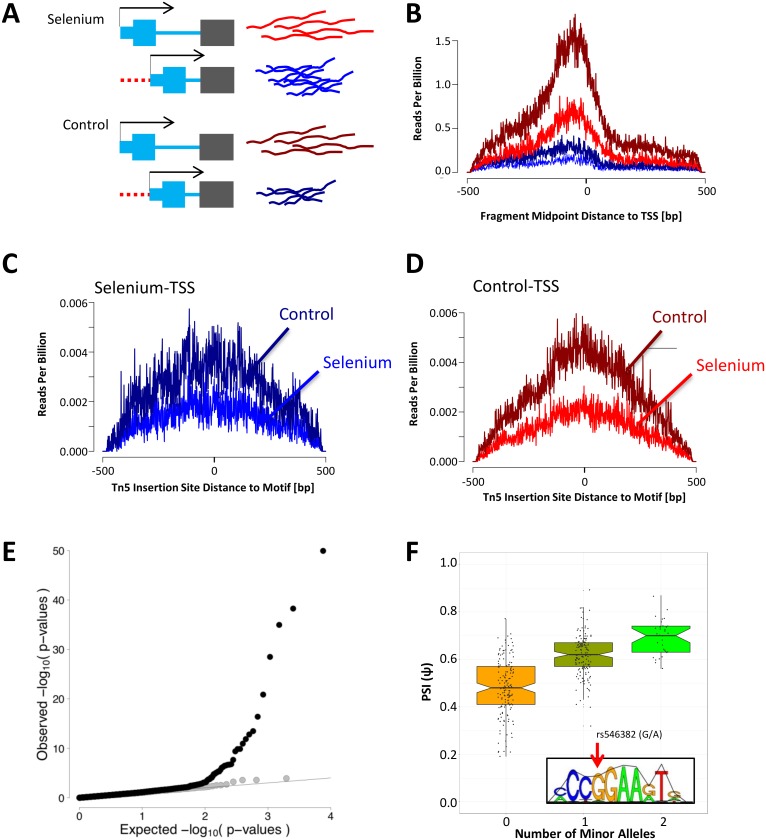
Binding of ELF2 impacts AFE shift following selenium treatment.A) Model illustrating the situation where transcription is shifted towards the downstream AFE following selenium treatment and demonstrates an example of a TSS that would be included in our analysis. B) Chromatin accessibility of TSS with significant shift in AFE following selenium measured by ATAC-seq (read count normalized to total reads in the library). Chromatin accessibility profiles derived from LCLs treated with selenium are bright blue or red, while profiles derived from LCLs treated with control are dark blue or red. Blue lines show accessibility at TSS to which the AFE shifts towards in selenium while red show the other TSS (as illustrated in A). C and D) ATAC-seq profiles centered on ELF2 motif locations within 1000bp of either TSS (colors are the same as in A and B) where C) shows accessibility of ELF2 motifs near TSS that are favored following selenium and D) shows accessibility of ELF2 motifs near TSS that are favored in the control samples. The difference in the ratio of treatment vs control read counts between the preferred and not preferred AFE is significant (BH pvalue = 2.0 × 10−3). E) QQ-plot of the AFE QTL p-values for SNPs in footprint of ELF2 (within cis region of an AFE event) that are predicted to influence binding (black) or not (gray). F) Association between genotype of SNP (rs546382) found in an ELF2 footprint and predicted to influence binding [48] and Ψ of AFE in IGHMBP2 across European individuals from the GEUVADIS data (p-value = 1.1 × 10−35). In the bottom right of the graph is the motif logo for ELF2 and the arrow indicates the position of the SNP.